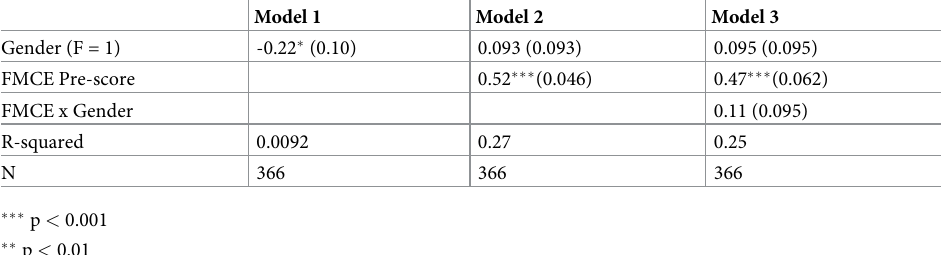
Table 2. Multivariable linear regression predicting the effects of gender and FMCE pre-scores on exam